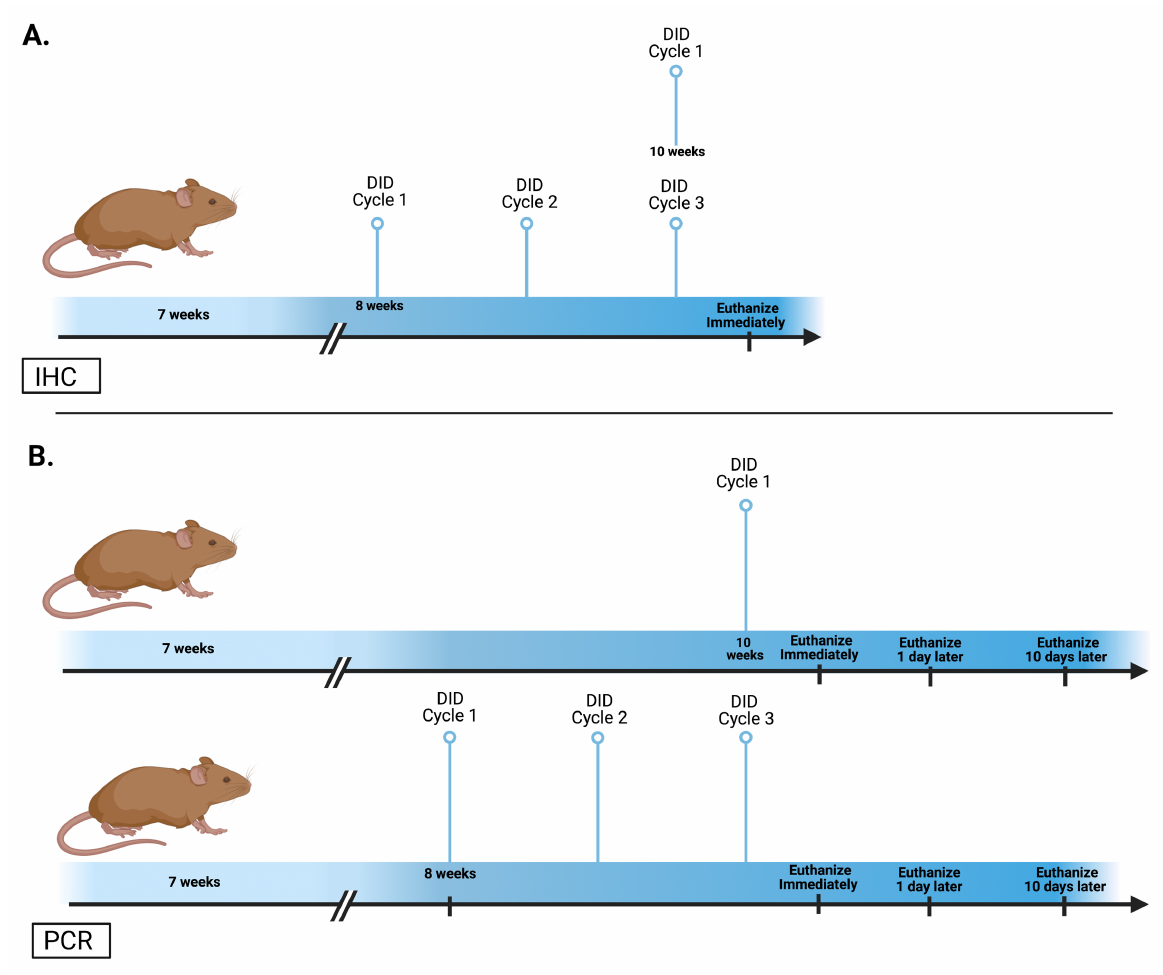
Fig. 1. Timeline of experimental procedures. C57BL/6J mice were used for either immunohistochemistry (A) or PCR (B) after ethanol. In the IHC, mice were given ethanol, water, or sucrose for 1 or 3 DID cycles and were euthanized immediately following their last dose. However, mice only had access to ethanol or water during the DID for PCR. Moreover, ethanol animals were further subdivided into 3 groups euthanized immediately or following 1 or 10 days of